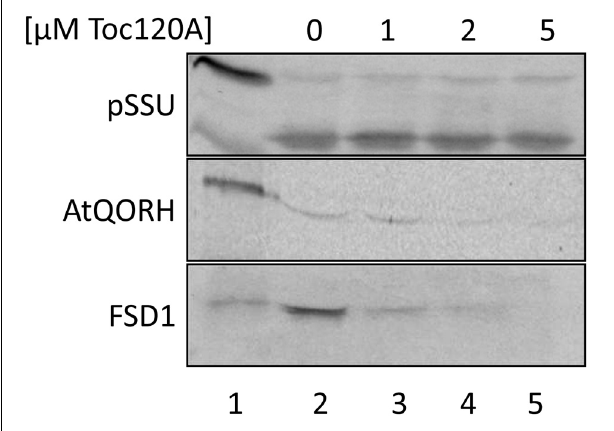
FIGURE 6 | FSD1 import is inhibited in the presence of psToc120 A-domain. In vitro import assays into pea chloroplasts are depicted. Lane 1 shows 10% of translation product. Increasing concentrations of purified psToc120 A-domain were incubated with in vitro translated chloroplast proteins prior to import. All samples were treated with thermolysin after the reaction. Representative results from n = 3 independent experiments are depicted.